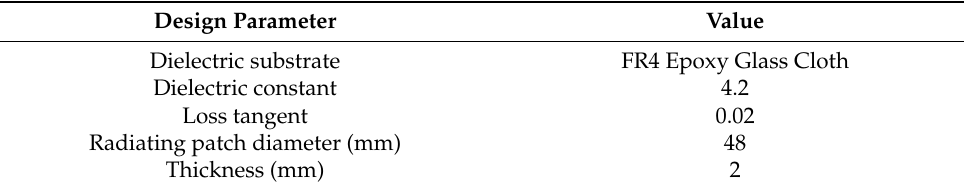
Table 1. Design parameters of the element of NDCPPA model verification prototype.